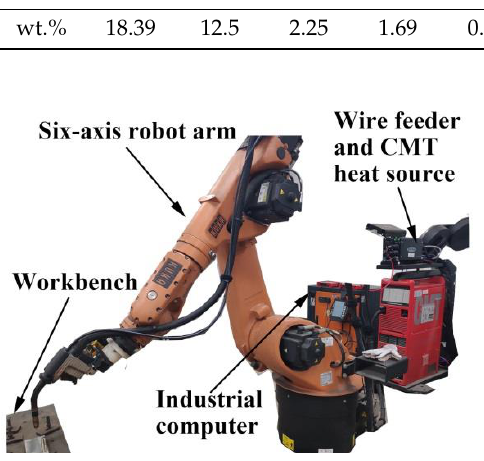
Table 1. Chemical composition of ER316L stainless steel wire. Element Cr